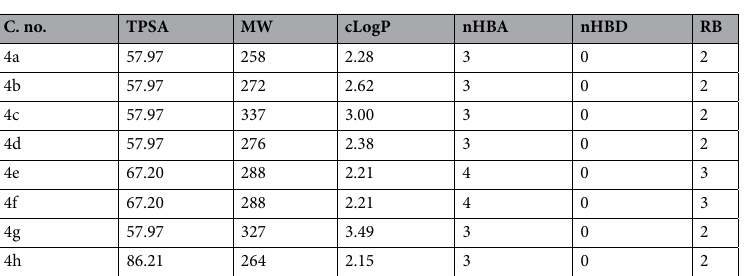
Table 2. Calculated Lipinski’s rule of five for tested compounds 4a–h . TPSA Total polar surface area, MW molecular weight, cLogP calculated lipophilicity, nHBA number of hydrogen bond acceptors, nHBD number of hydrogen bond donors, RB rotatable